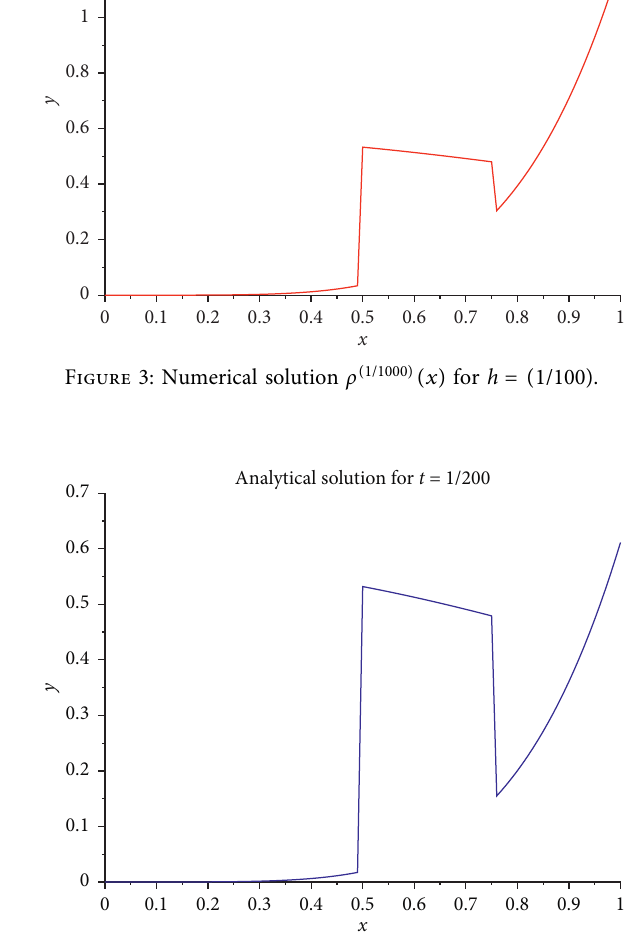
Figure 4: Analytical solution ρ (( 1/200 ) ,x ) for h � ( 1/100 ) and t � ( 1/2000 ) ∈ ( 0 , ( 1/1000 )]